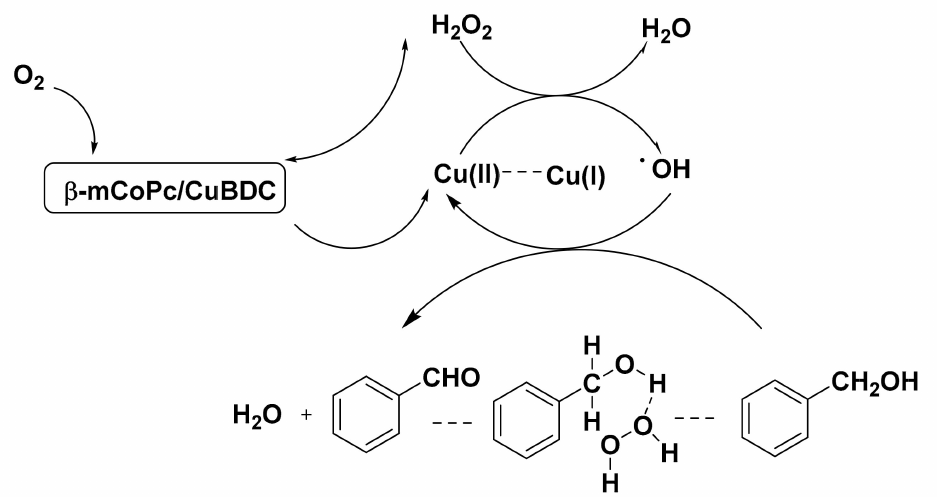
Figure 3. Proposed mechanism for the oxidation of benzyl alcohol to benzaldehyde with β -